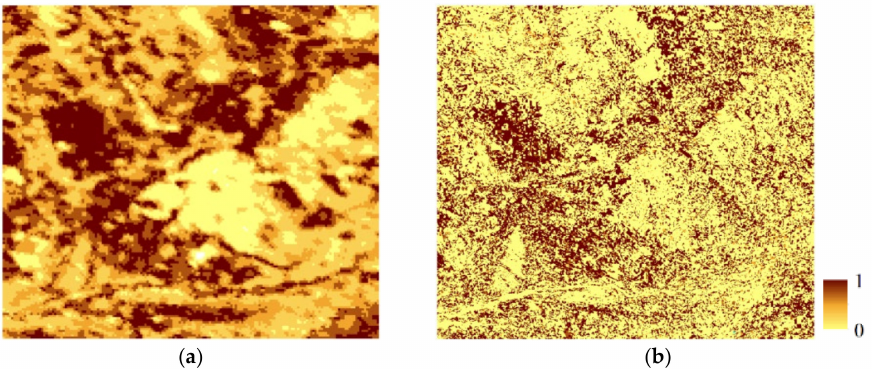
Figure 8. Memberships of grassland from ( a ) MODIS data; ( b ) Landsat data. The membership value is between 0 and